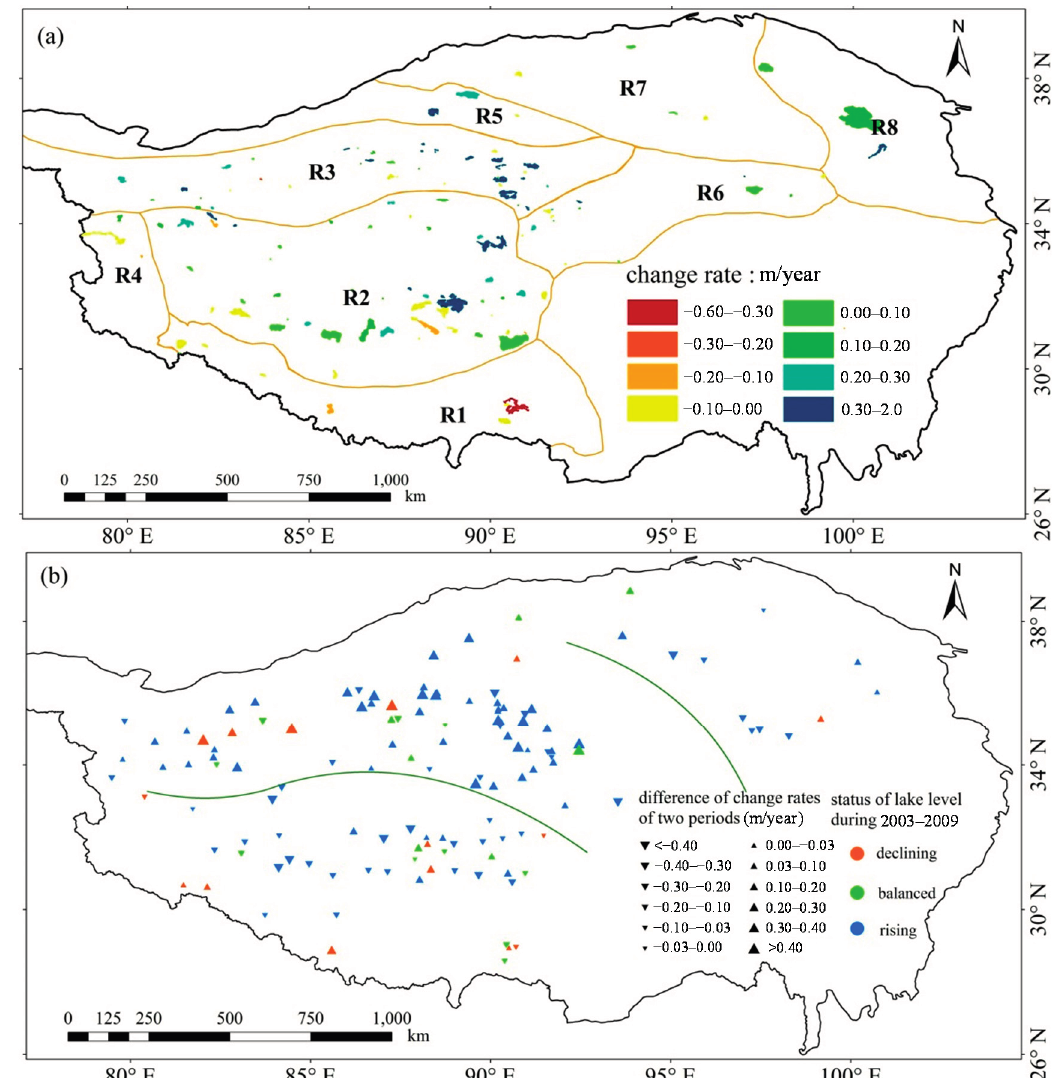
Figure 3. Water-level change of Tibetan lakes derived from combined ICESat and CryoSat-2 measurements. ( a ) Change rates of lake level during 2003–2014; ( b ) difference of change rates of lake level between the two periods 2003–2009 and 2010–2014. R1-8 show eight sub-zones with different geographic and climatic features: R1, South Tibet temperate and semi-arid; R2, southern Changtang subarctic and semi-arid; R3, northern Changtang subarctic and arid; R4, western TP temperate and arid; R5, northern Kunlun temperate and arid; R6, Central Qinghai subarctic and semi-humid; R7, Qaidam Basin temperate and arid; R8, northeastern Tibetan Plateau temperate and